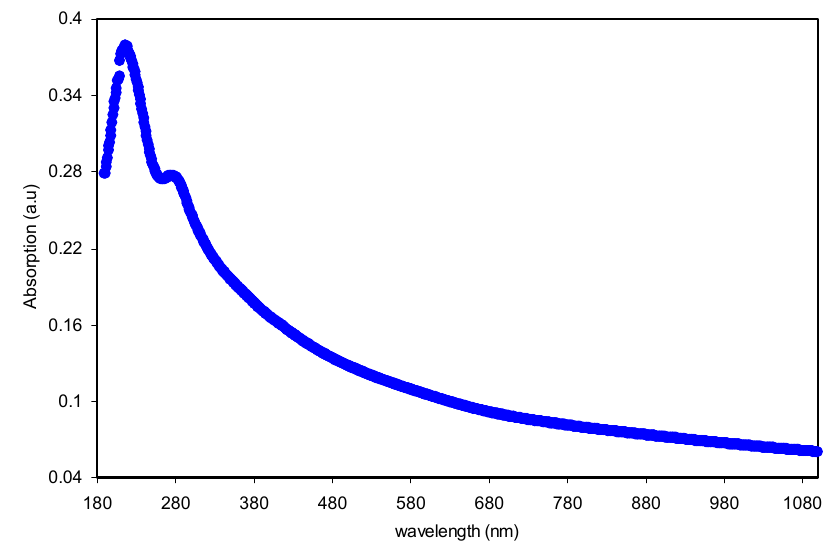
Figure 6. Absorptionspectra for colloidal suspension of copper complex.